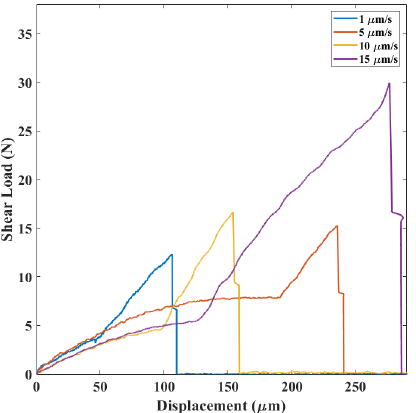
Figure 8. Load-displacement results in category B.